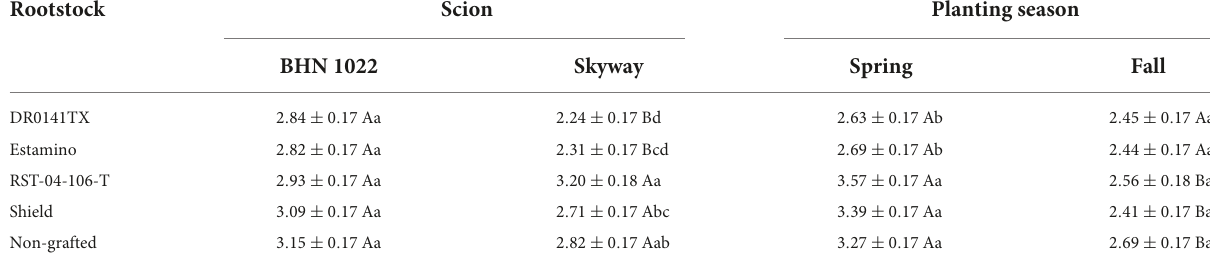
TABLE 5 Fruit firmness (kgf) of fruit from grafted beefsteak tomato ‘Skyway’ and grape tomato ‘BHN 1022’ in Spring and Fall plantings.